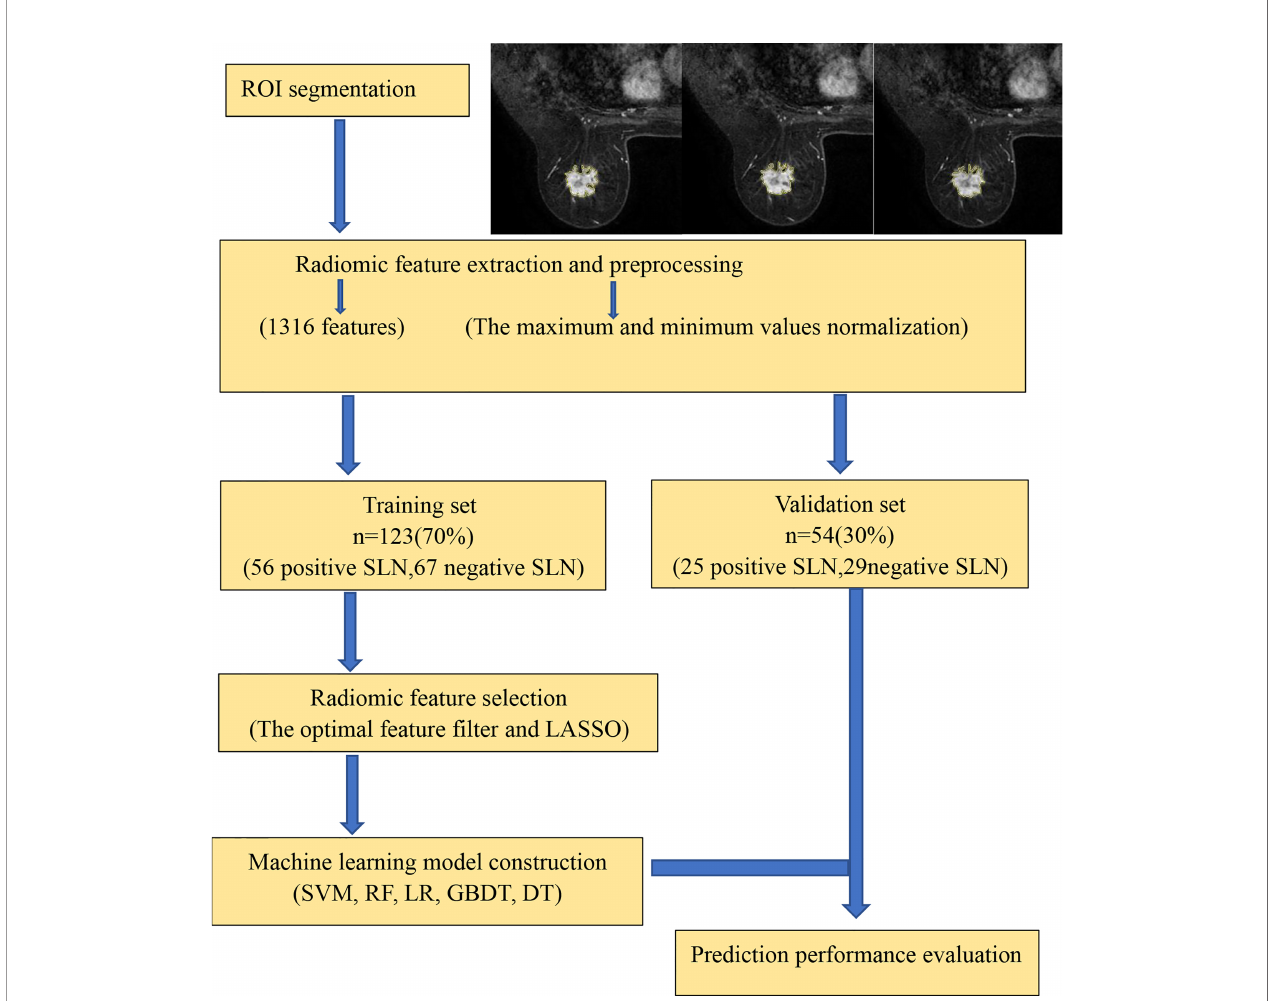
FIGURE 1 | Radiomics work fl